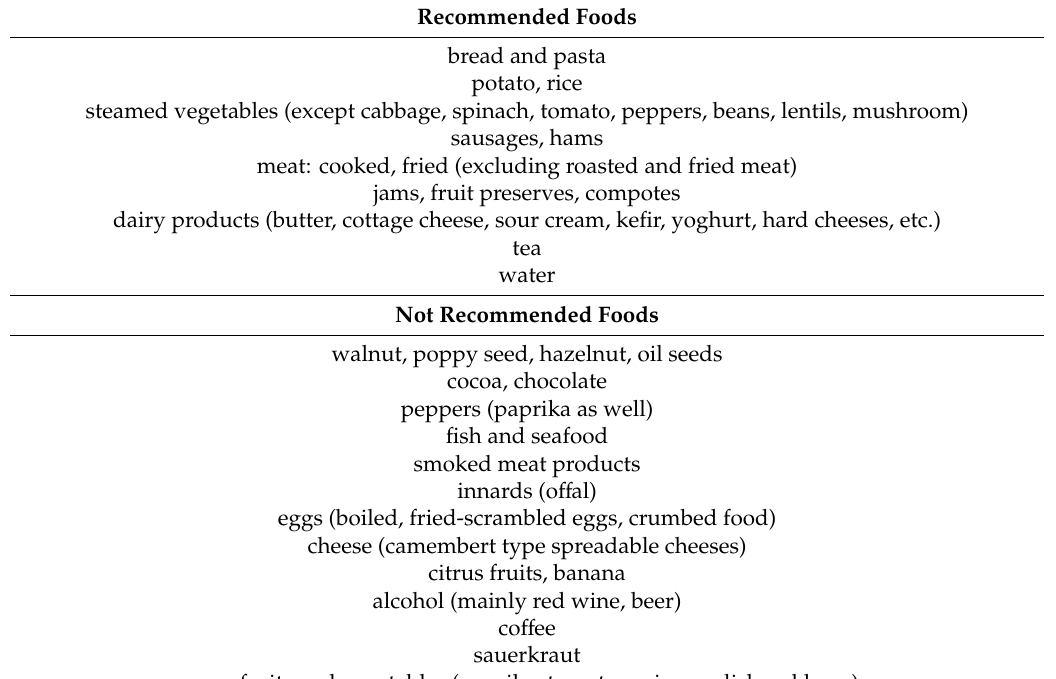
Table 3. Recommended foods and foods to avoid during a diet low in biogenic